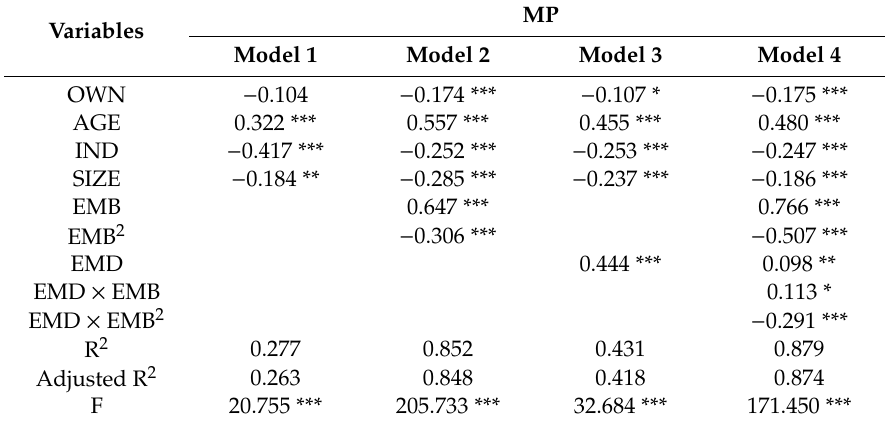
Table 3. Results of regression analysis.